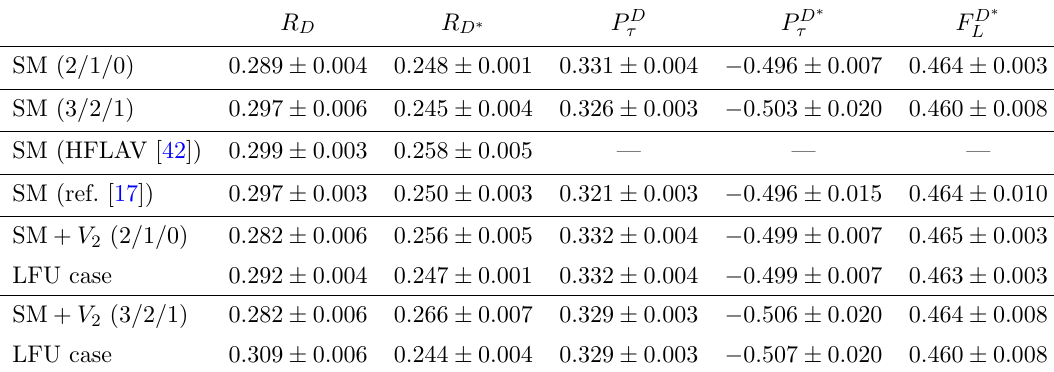
D ( (cid:3) ) (cid:28) (cid:22) (cid:23) !